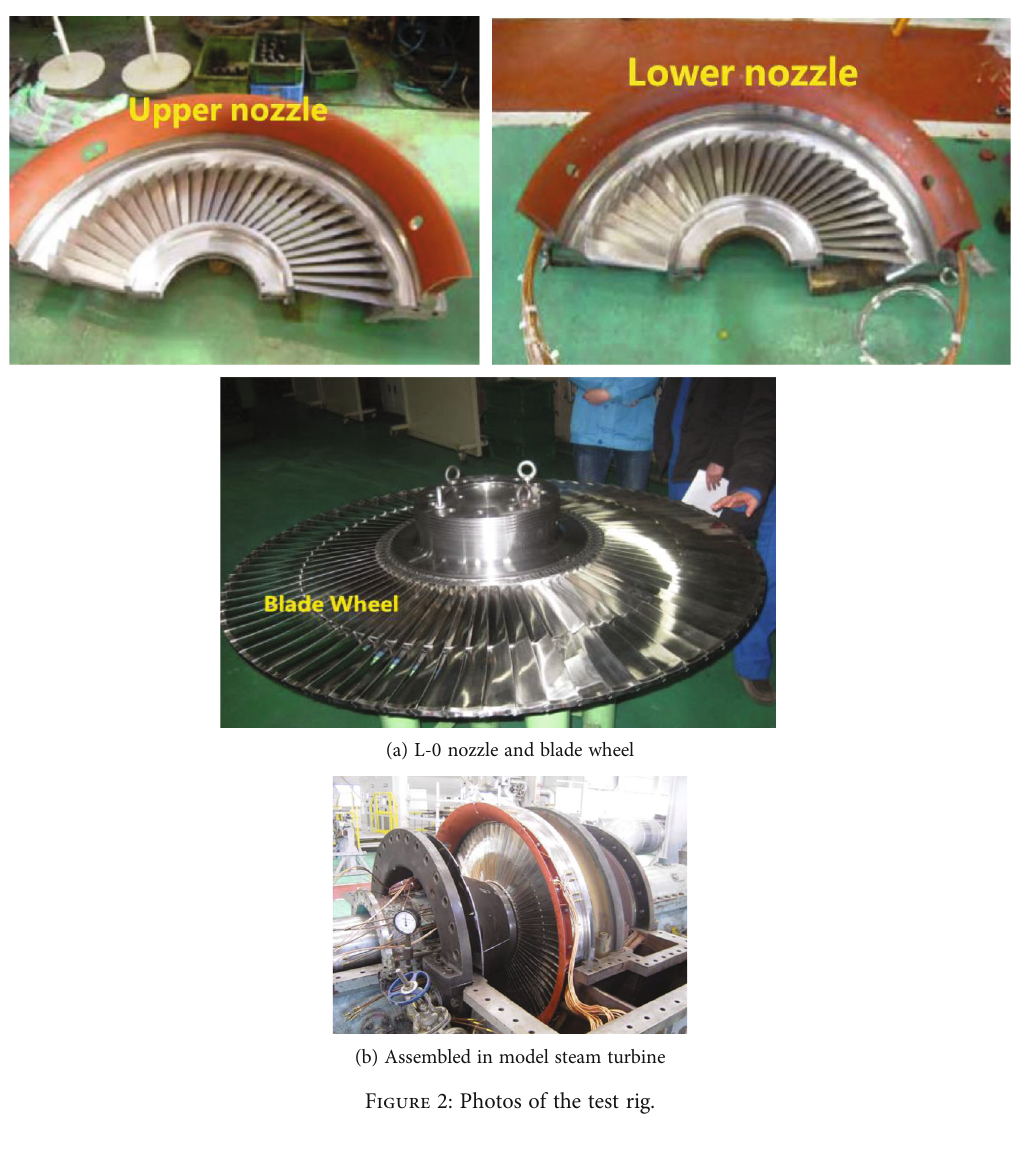
Figure 2: Photos of the test